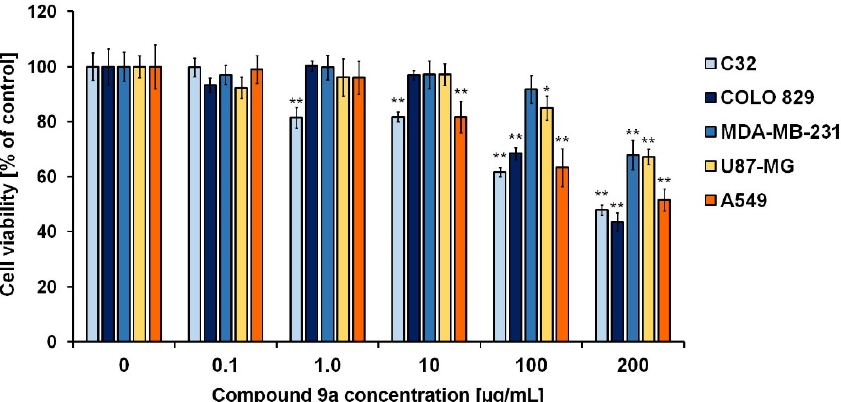
Figure 8. Cell viability data from panels of cancer cell lines treated with compound 9a in the indicated concentrations for 72 h. Data expressed as a percentage of and presented as the mean values ± SD of three independent experiments. Statistical significance of difference was tested by one-way ANOVA with Dunnet’s post hoc test, * p < 0.05, ** p < 0.005 vs control.